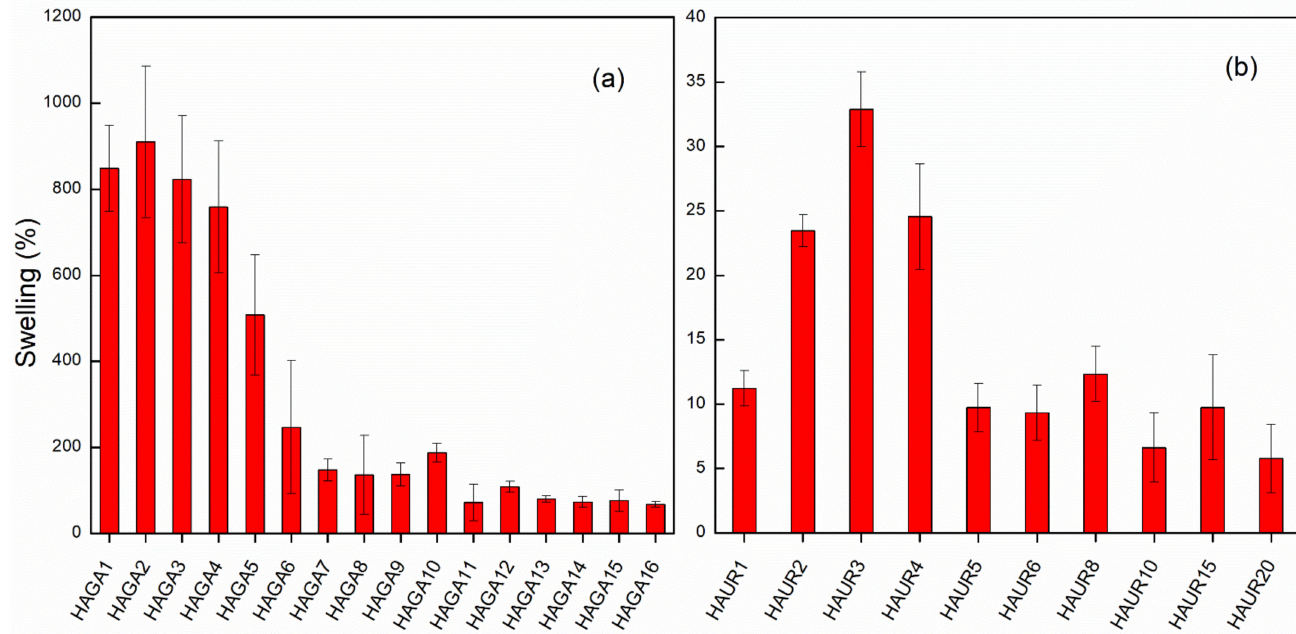
Figure 2. Swelling in deionized water of HA films crosslinked with GA after 24 h ( a ) and UR after 2 h ( b ) with various crosslinker concentrations. Bars represent the standard error of the